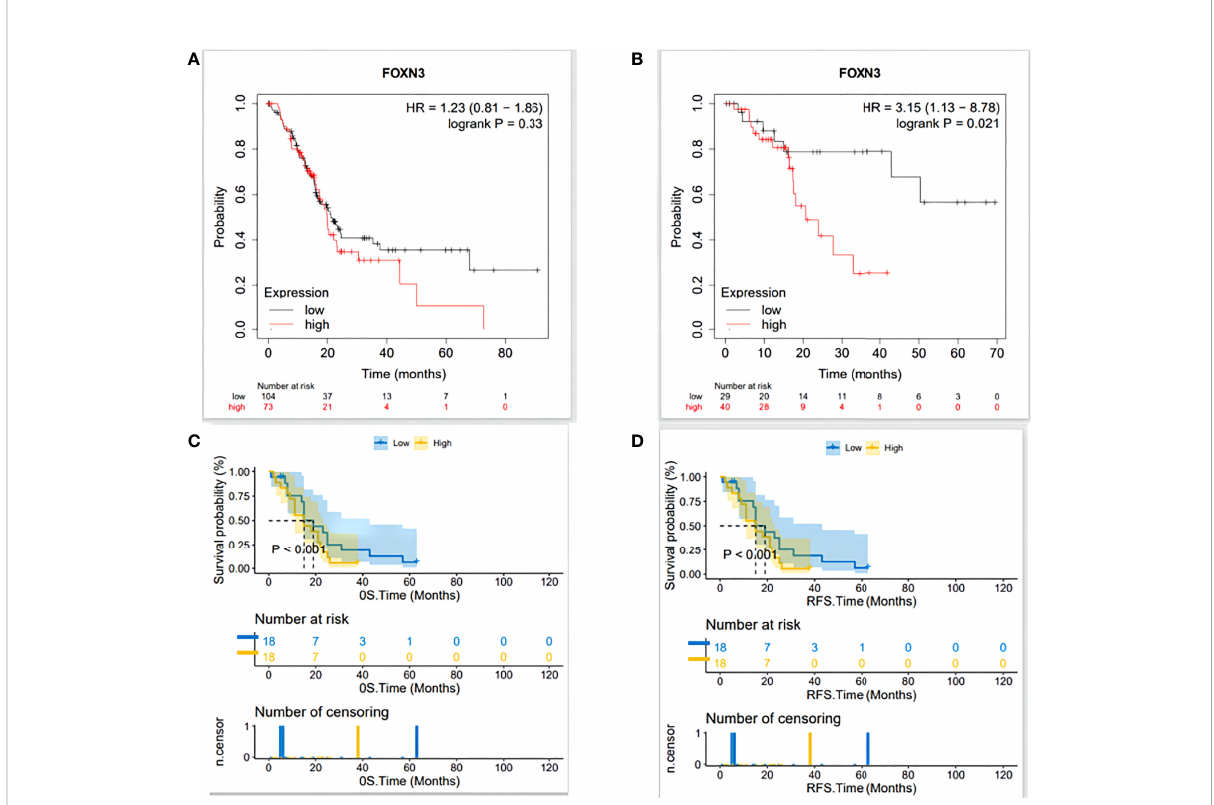
FIGURE 4 (A) The relationship between FOXN3 expression level and overall survival in TCGA database analyzed by Kaplan-Meier Plotter. (B) The relationship between FOXN3 expression level and disease-free survival in TCGA database by Kaplan-Meier Plotter. (C) The relationship between FOXN3 expression level and overall survival in clinical samples. (D) The relationship between FOXN3 expression level and disease-free survival in clinical samples.